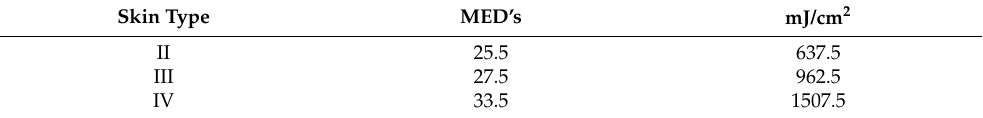
Table 5. Recommended cumulative UVB irradiation dose during a 2-week stay at the Dead Sea *.